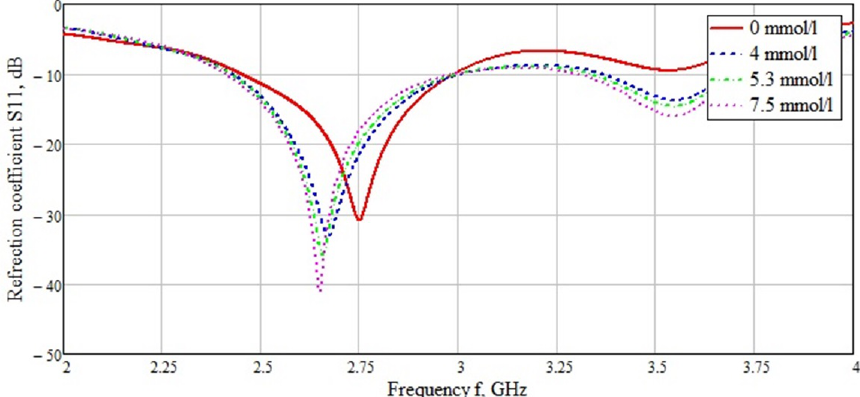
Figure 8. Frequency dependence of the reflected signal for various glucose